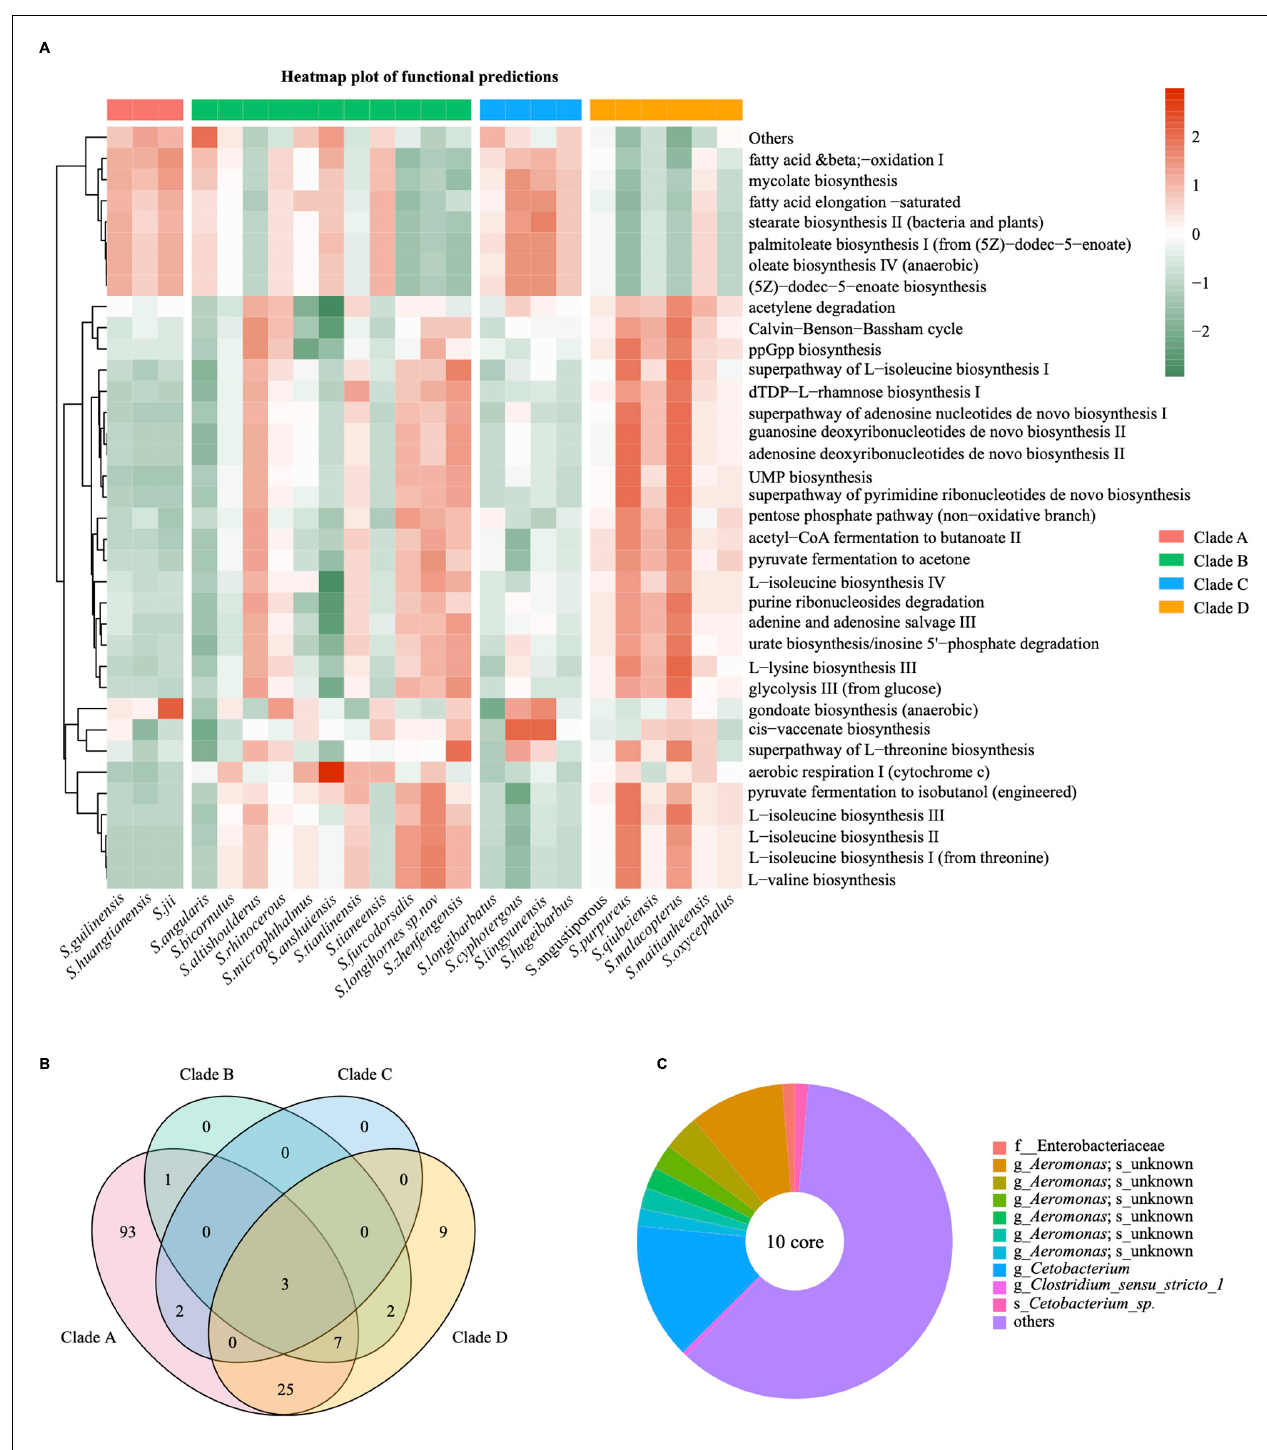
FIGURE 6 | Functional characteristics of main bacterial taxa and the core microbiome in Sinocyclocheilus species ( N = 24). (A) Heatmap illustrating the metabolic and ecological functions of gut bacteria in different species of cavefishes based on MetaCyc database. The color scale of higher (red) and lower (blue) shows the functional characteristics in the fish species. (B) Venn diagram showing the number of shared and unique ASVs among the Sinocyclocheilus species ( N = 24) belonging to four clades. (C) Diagram representing the core microbiome in Sinocyclocheilus species ( N = 24).